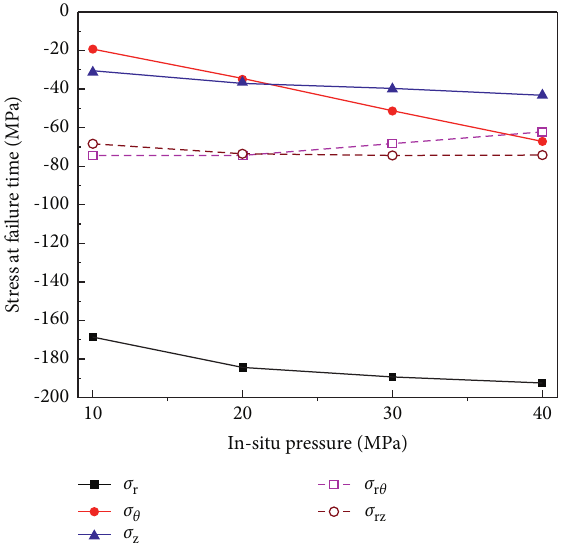
Figure 14: Three principal stresses and max shear stresses at the failure time as a function of in situ